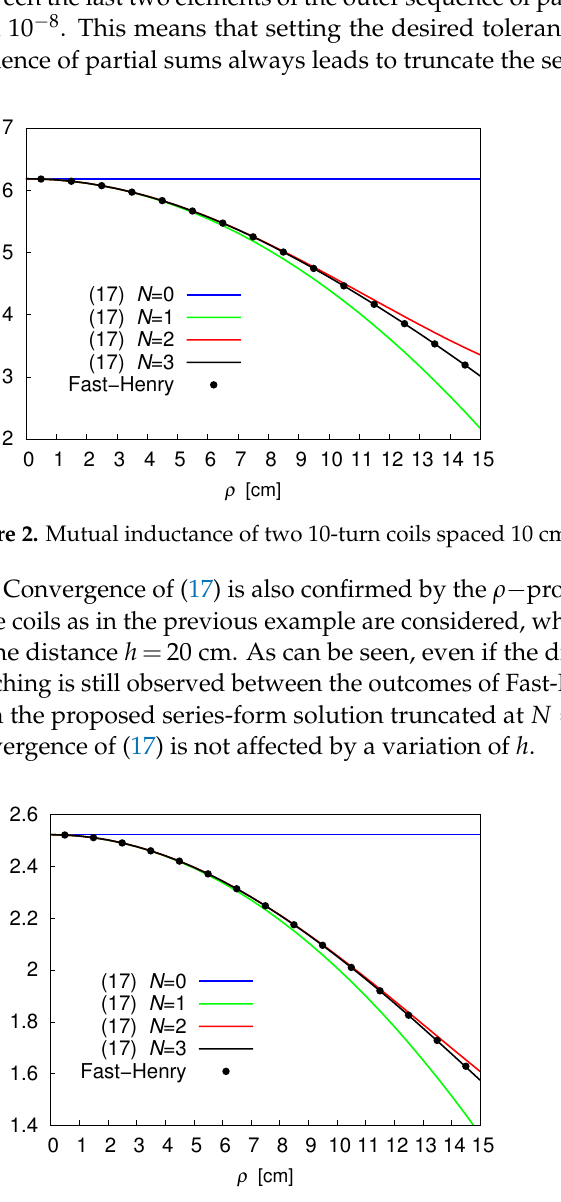
Figure 3. Mutual inductance of two 10-turn coils spaced 20 cm apart, as a function of ρ